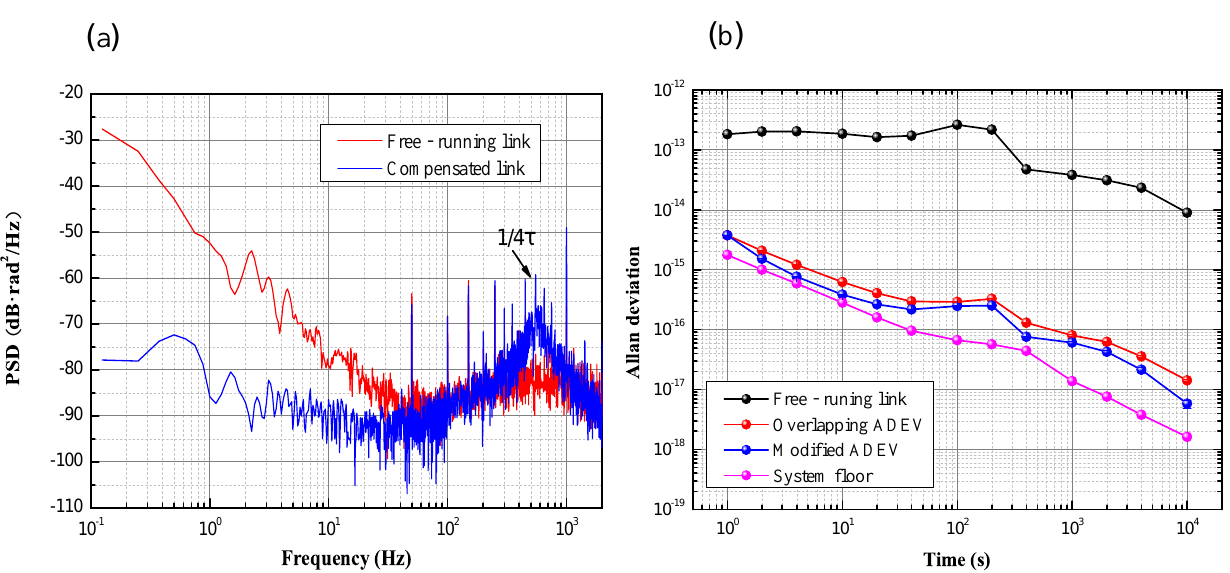
Figure 5. ( a ) The phase noise of the 10 GHz microwave frequency transfer, where the red curve is the phase noise of the free-running link, and the blue curve is the phase noise of the compensated link. ( b ) The Allan deviation of the 10 GHz microwave frequency transfer, where the black dot curve is the free-running link, the red dot curve is the compensated link overlapping ADEV, while the blue dot curve is the modified ADEV, and the pink dot curve is the 1-m tranfer link system